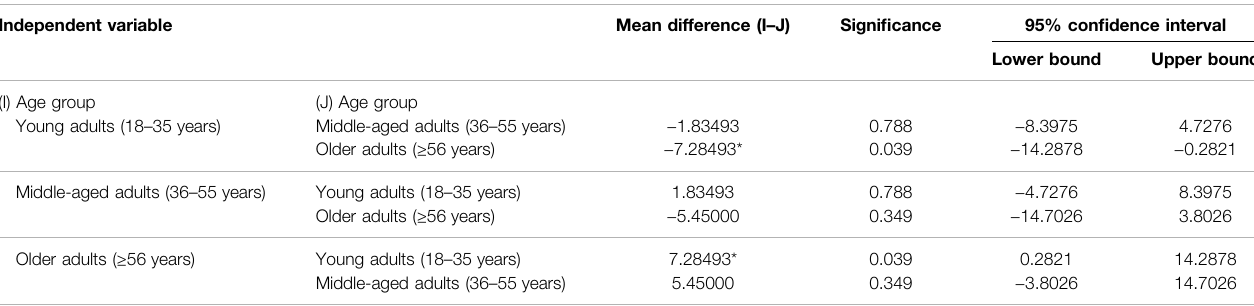
TABLE 10 | Post hoc test for daily travel cost with age group. Independent